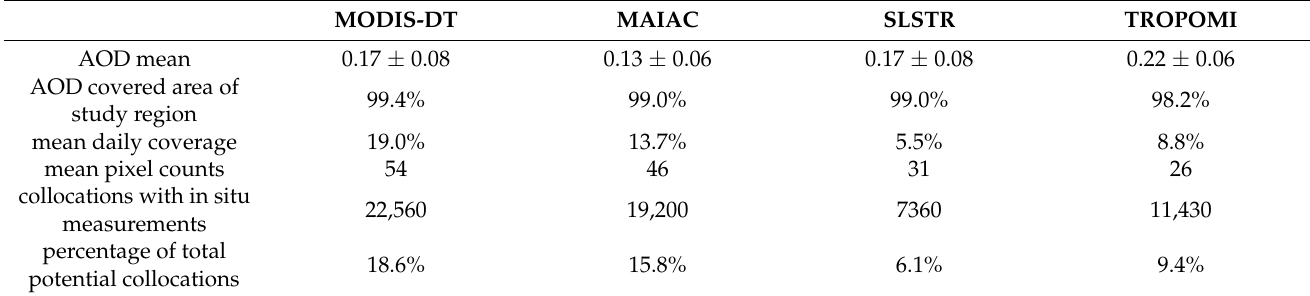
Table 3. Some basic numbers on the different AOD datasets for the year